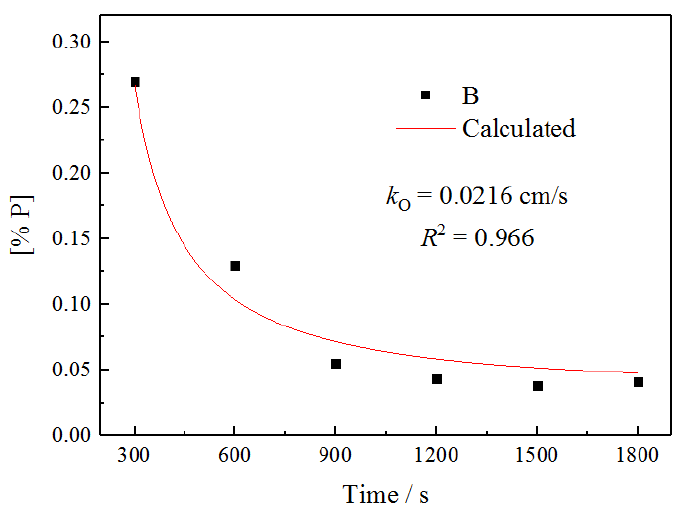
Figure 7. Fitting results of experiment B data.